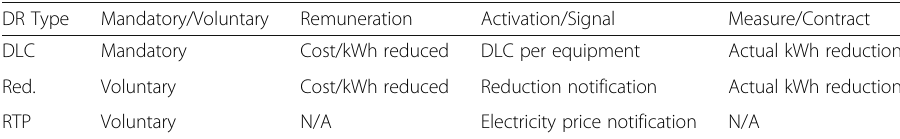
Table 1 DR Programs proposed by the CSP to customers DR